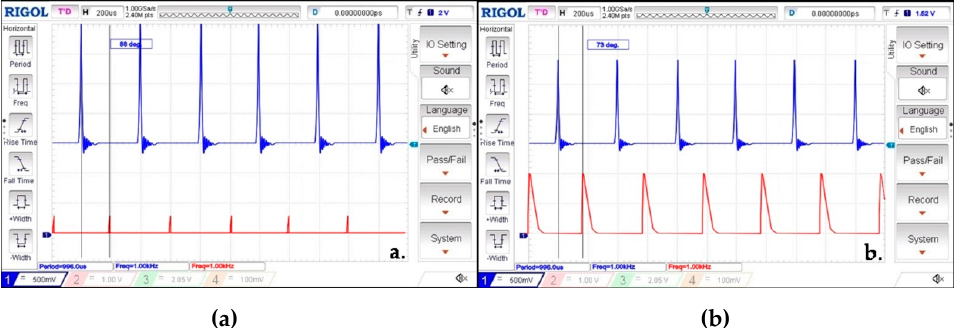
Figure 7. The voltage and the current waveforms for no load regime ( a ) and the voltage and the current waveforms for the ignited plasma regime ( b